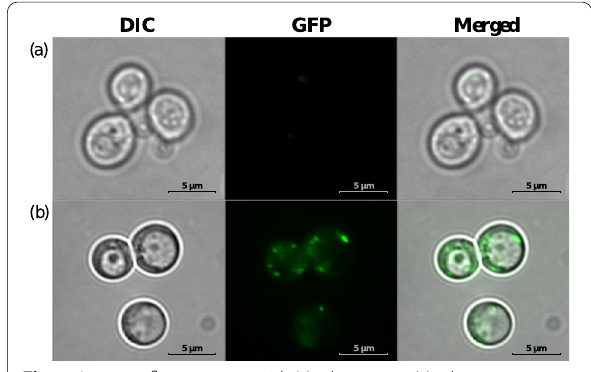
Fig. 1 Immunofluorescence with Mock vector. a Mock vector. b GWL‑1 cells. To confirm the expression of recombinant protein, we performed Immunofluorescence. A fluorescent secondary antibody was attached to the recombinant protein of the induced cells. As a control, Mock was used. While the control did not show fluorescence, fluorescence was successfully expressed in GWL‑1 cells